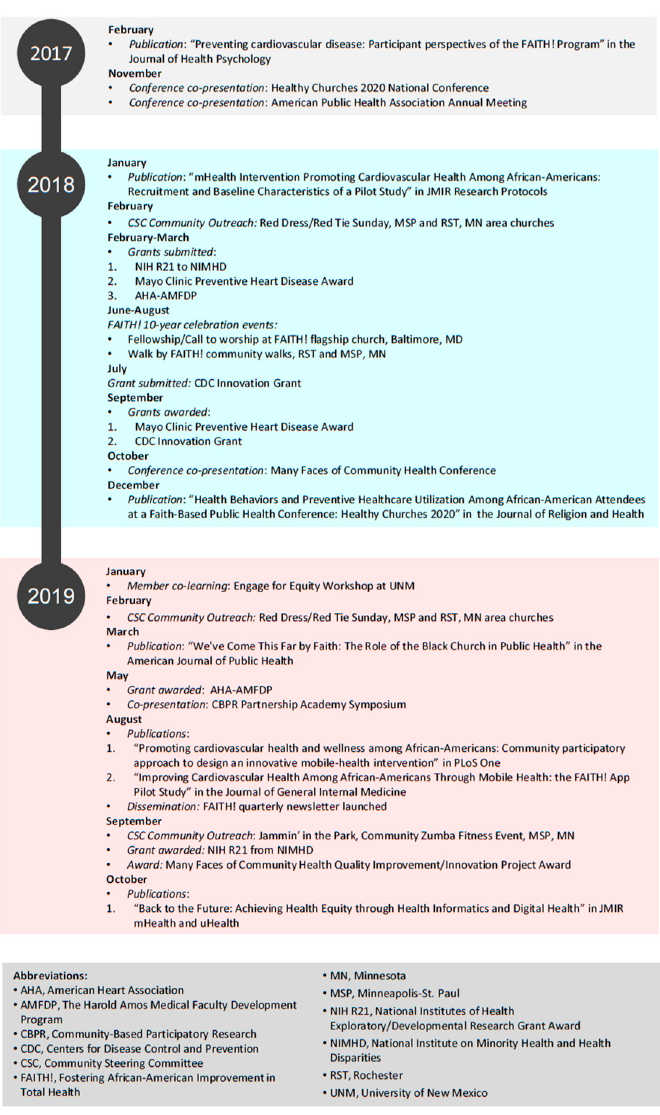
Figure 4. FAITH! Community Steering Committee Activities and Accomplishments.